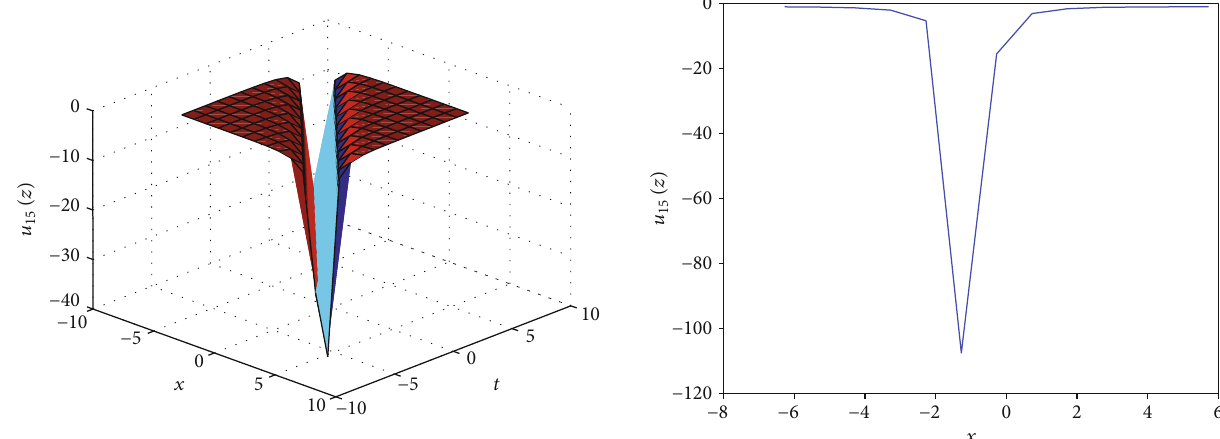
ð z Þ by choosing the values γ = 2 , ϑ = 0 , λ = 1 , ω = 1 , c = 1 , and t = 0 for the 2D Figure 5: The 3D and 2D graphics of u 15